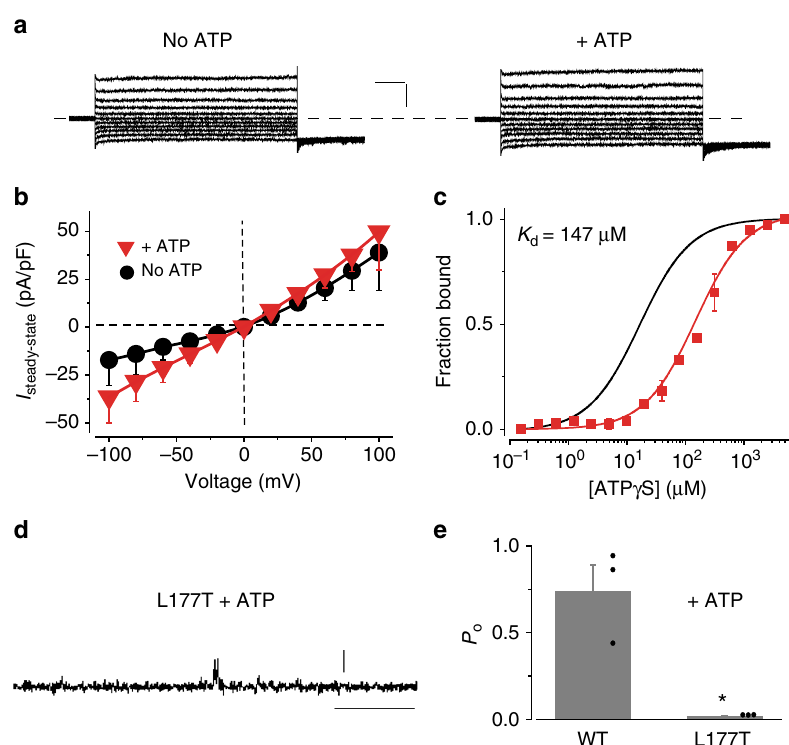
Fig. 6 The in fl uence of a patient-speci fi c mutation on ATP-dependent activation. a Representative current traces recorded from hBest1 I201T iPSC-RPE in the absence or presence of 2 mM ATP (Scale bar, 300 pA, 100 ms). b Population steady-state current – voltage relationships in hBest1 I201T iPSC-RPE in the absence or presence of 2 mM ATP; n = 5 – 6 for each point. c The MST binding curves of KpBest L177T (red) to ATP γ S. Protein fraction bound vs. [ATP γ S], n = 3 for each point. The binding curve of WT KpBest to ATP γ S (black) is shown for comparison. d Representative current trace of single KpBest L177T mutant channel recorded from planar lipid bilayers at 80 mV in the presence of 2 mM ATP (Scale bar, 2 pA, 250 ms). e Bar chart showing the open probability of KpBest WT and L177T channels in the presence of 2 mM ATP, n = 3 for each bar. * P < 0.05 compared to the open probability of WT KpBest in the presence of ATP, using two-tailed unpaired Student t test. All error bars in this fi gure represent